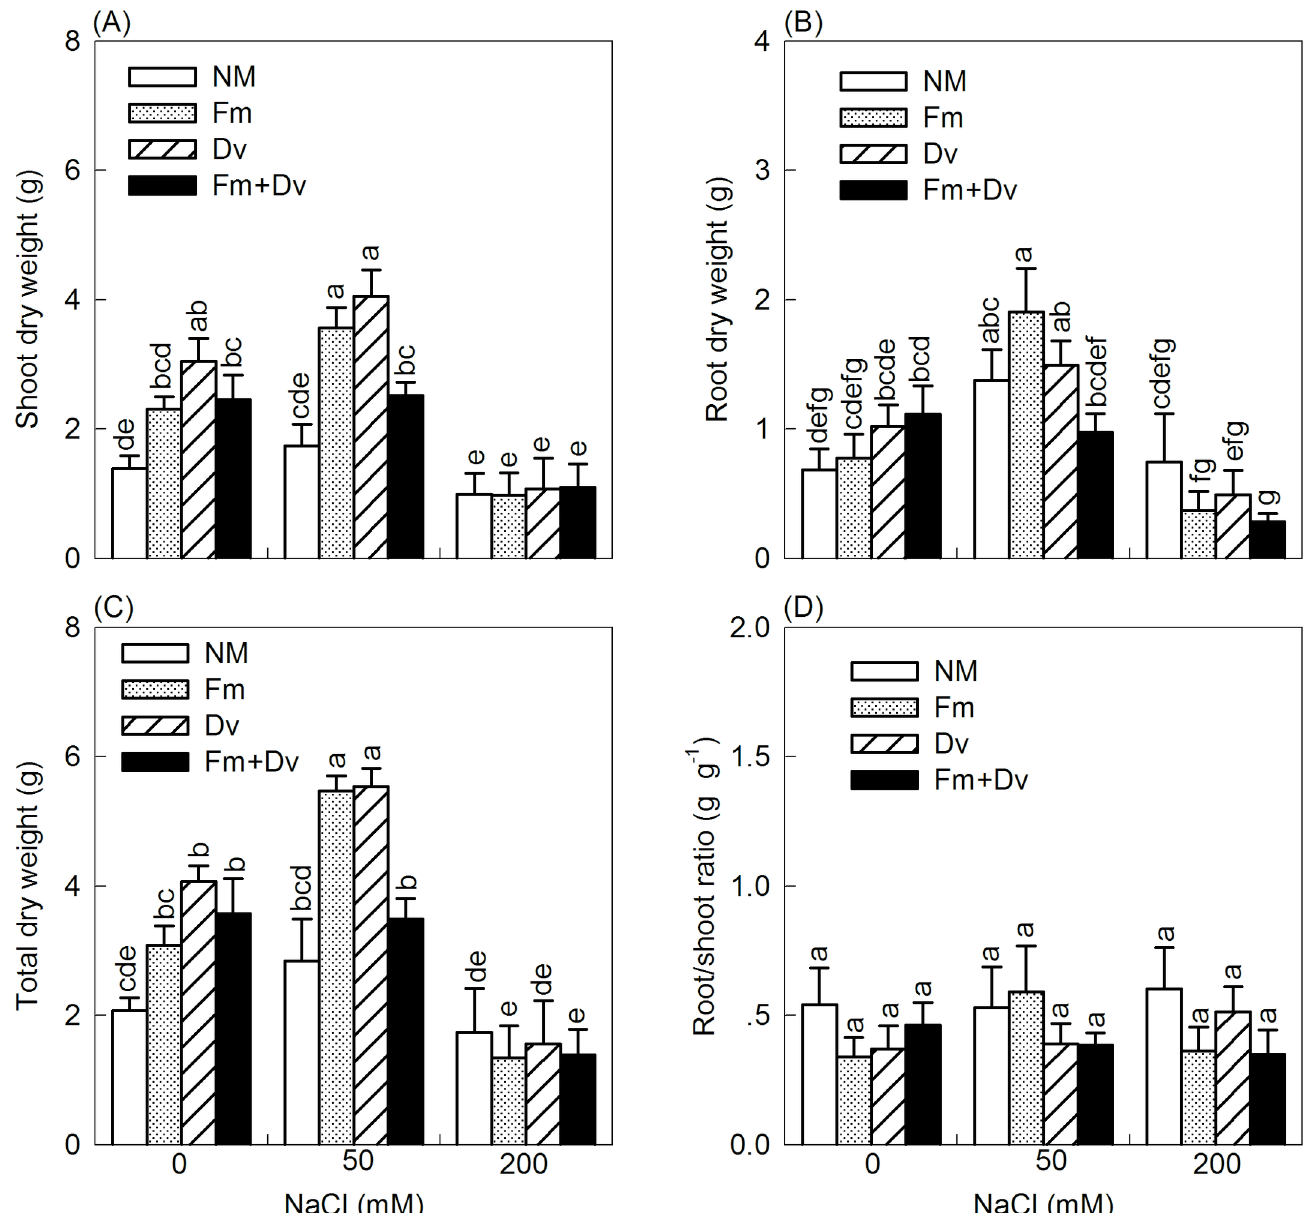
Fig 2. Effects of arbuscular mycorrhizal fungi on shoot dry weight (A), root dry weight (B), total dry weight (C) and root/shoot ratio (D) of C . morifolium plants under 0, 50 and 200 mM NaCl. Symbols are the same as in Fig 1.